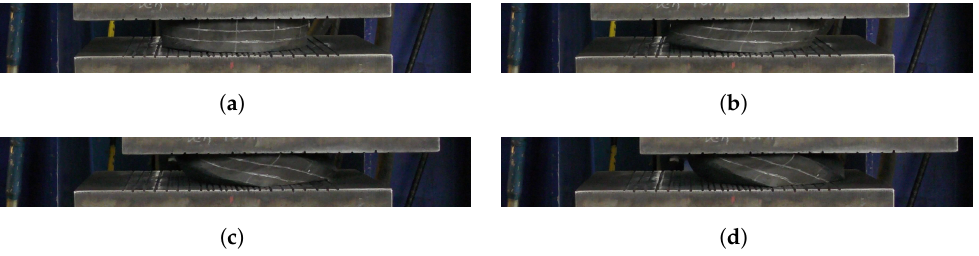
Figure 1. Lateral cyclic tests on FREB. ( a ) u h = 0% t r . ( b ) u h = 1.0% t r ( c ) u h = 1.5% t r . ( d ) u h = 2.0% t r